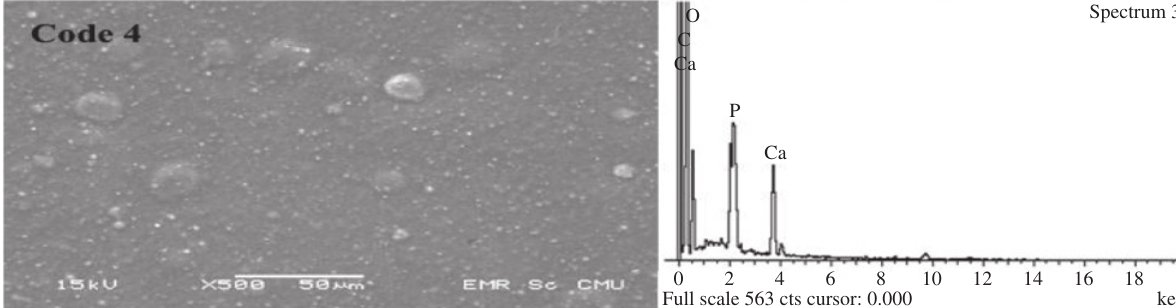
Figure 3: Workpiece surface and elemental measurement (Code 4).